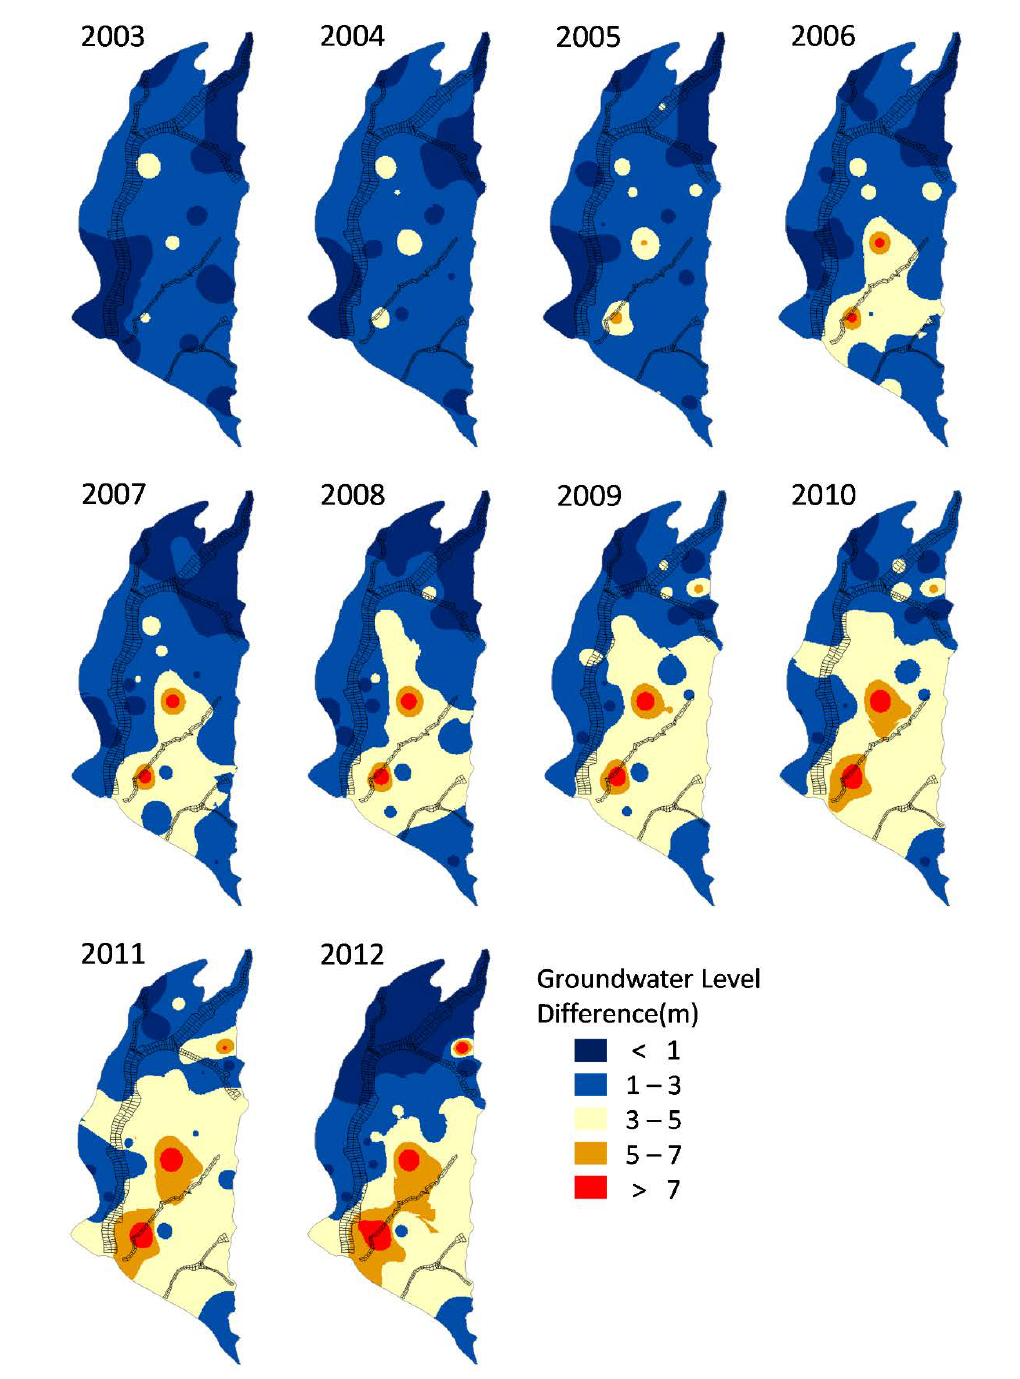
Figure 12. Evolution of the spatial patterns of groundwater level differences (simulated minus observed data) for the 10-year